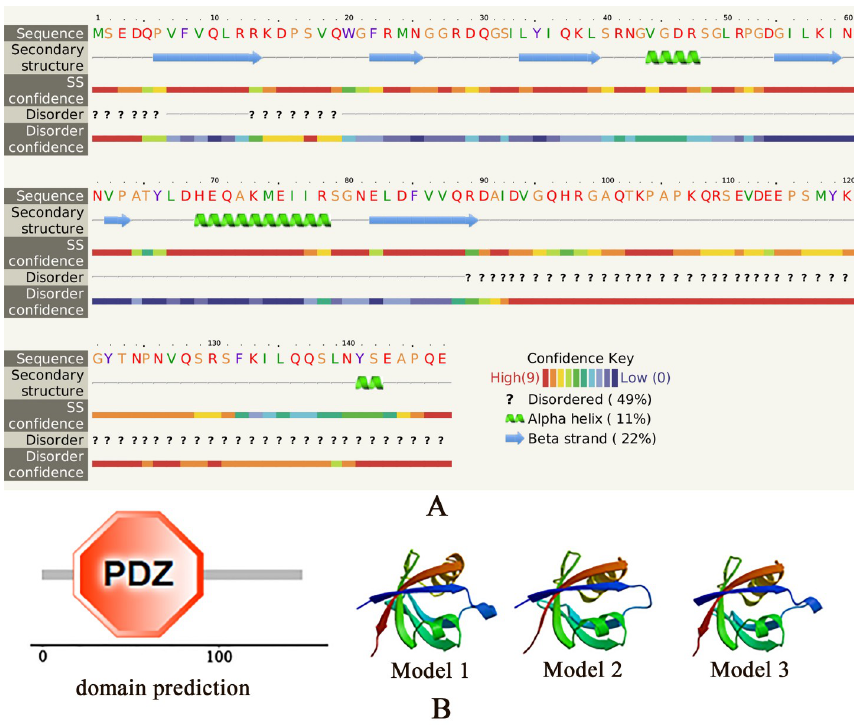
Fig 1. The structural features of WLP. A: the secondary structure of WLP predicted by Phyre. The regions adopting putative α -helix and β -sheet are represented as spiral and arrow, respectively. B: the domain prediction and spatial structure of WLP. Domain of WLP was predicted by SMART and one PDZ domain was showed. Spatial structure of WLP was predicted by SWISS-MODEL. Model 1~3 represent the predicted structures with highest score using 6qji.4. A, 6qji.6.A, and 6qji.1.A as templates, respectively.